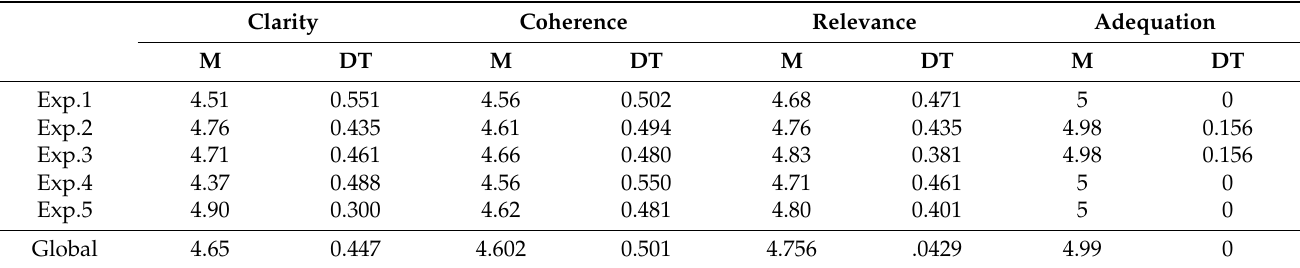
Table 2. Results obtained according to the five